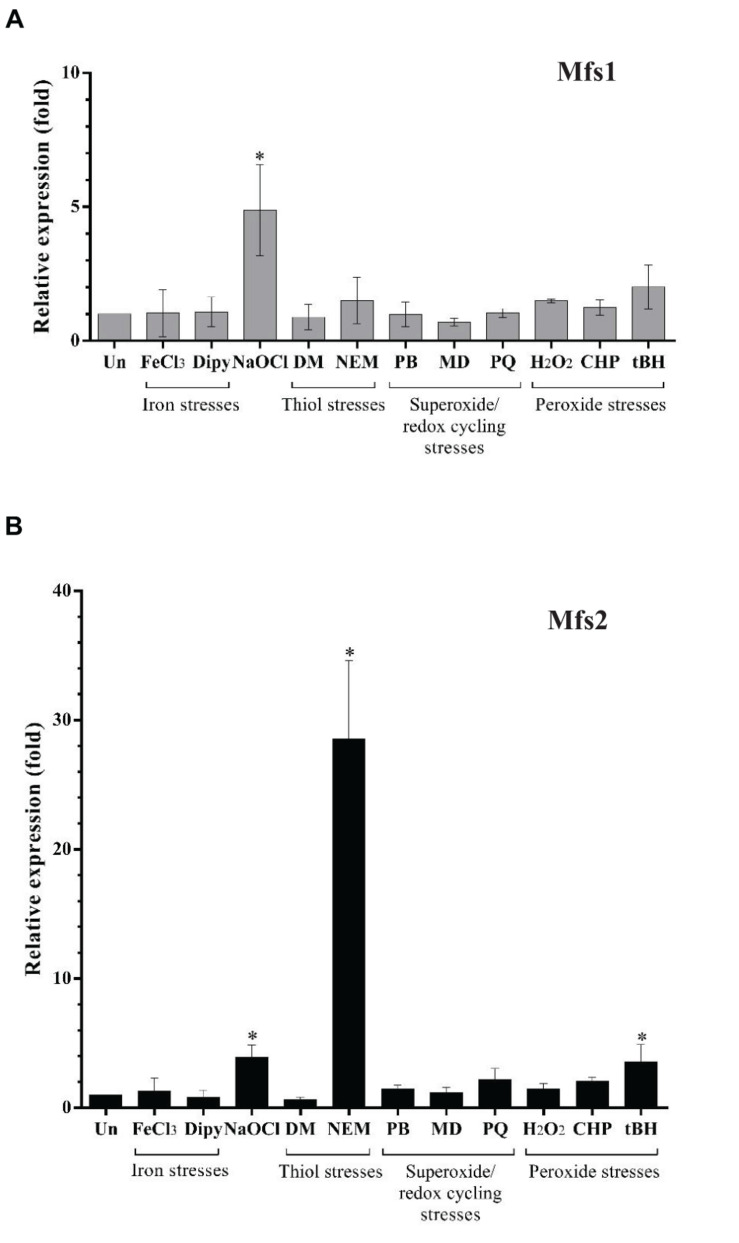
Relative expression of (A)
mfs1 and (B)
mfs2 in response to stresses in PAO1 wild-type, determined by semi-quantitative real-time RT-PCR. Mid-log phase PAO1 wild-type cells were treated with 100 μM of iron (FeCl3), 100 μM of iron depletion agent, 2,2′-Bipyridine (Dipy), 0.02% of NaOCl, 500 μM of diamide (DM), 100 μM of N-Ethylmaleimide (NEM), 250 μM of plumbagin (PB), 1 mM of menadione (MD) 1 mM of paraquat (PQ), 1 mM of hydrogen peroxide (H2O2), 500 μM of cumene peroxide (CHP), and 500 μM of t-butyl hydroperoxide (tBH) for 15 min. After normalizing data with internal control (16S rRNA), gene expression in each condition was compared to the untreated control (Un) and fold changes were calculated. Data presented are means ± SD of three biological replicates. Asterisk (∗) indicates significant difference relative to untreated (Un) (p-value < 0.05).